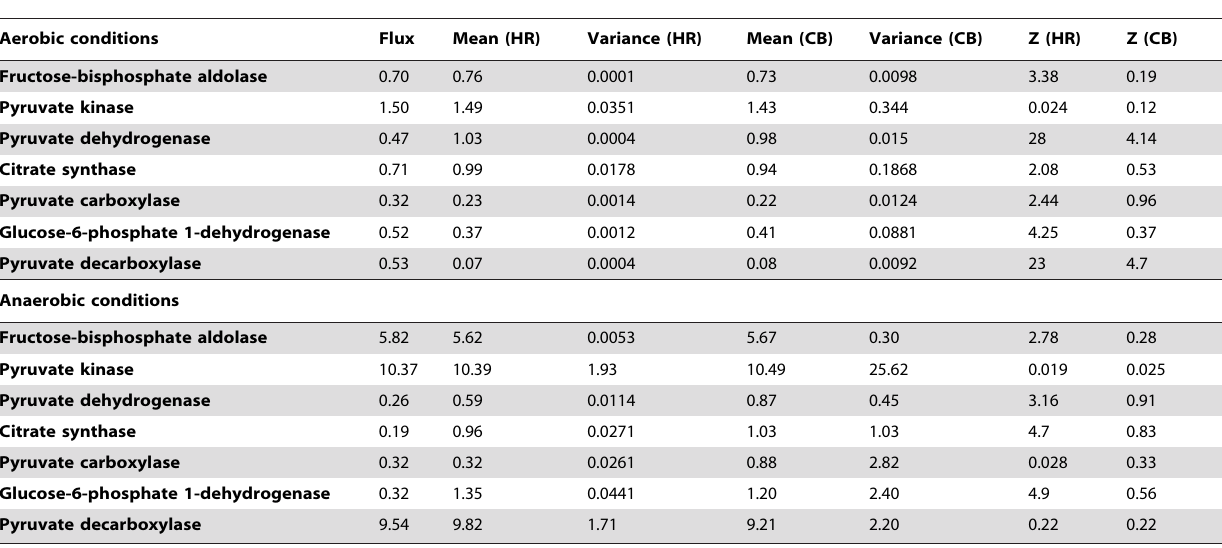
Table 1. Real and estimated fluxes in S. cerevisiae at aerobic and anaerobic growth conditions.